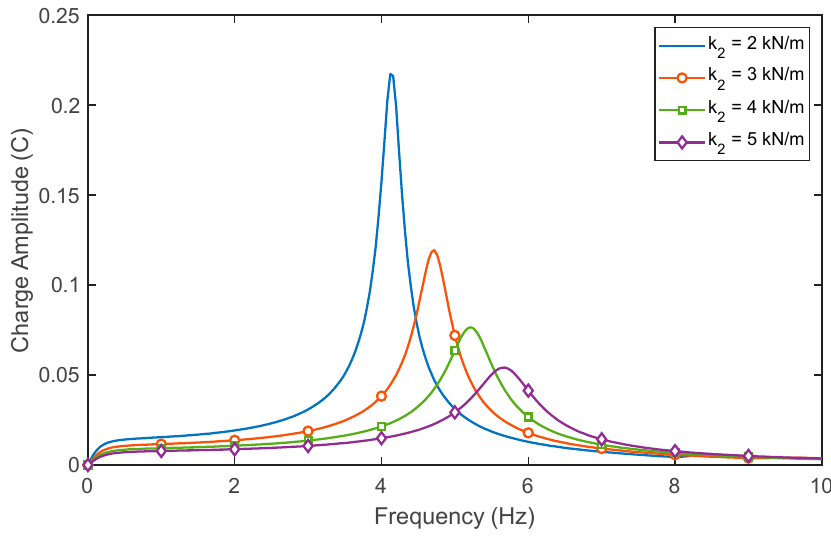
Figure 4. Frequency spectrum of the output charge at different values of the spring stiffness.